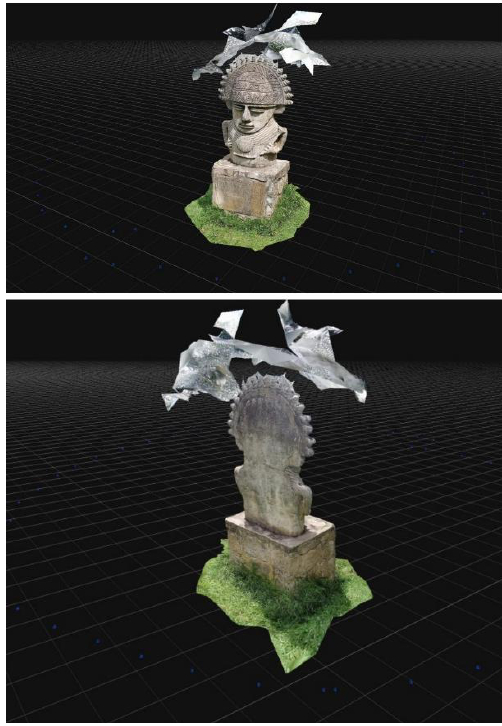
Figure 7. Petroglyph reconstruction, texture mesh. Videogrammetric method with ordered